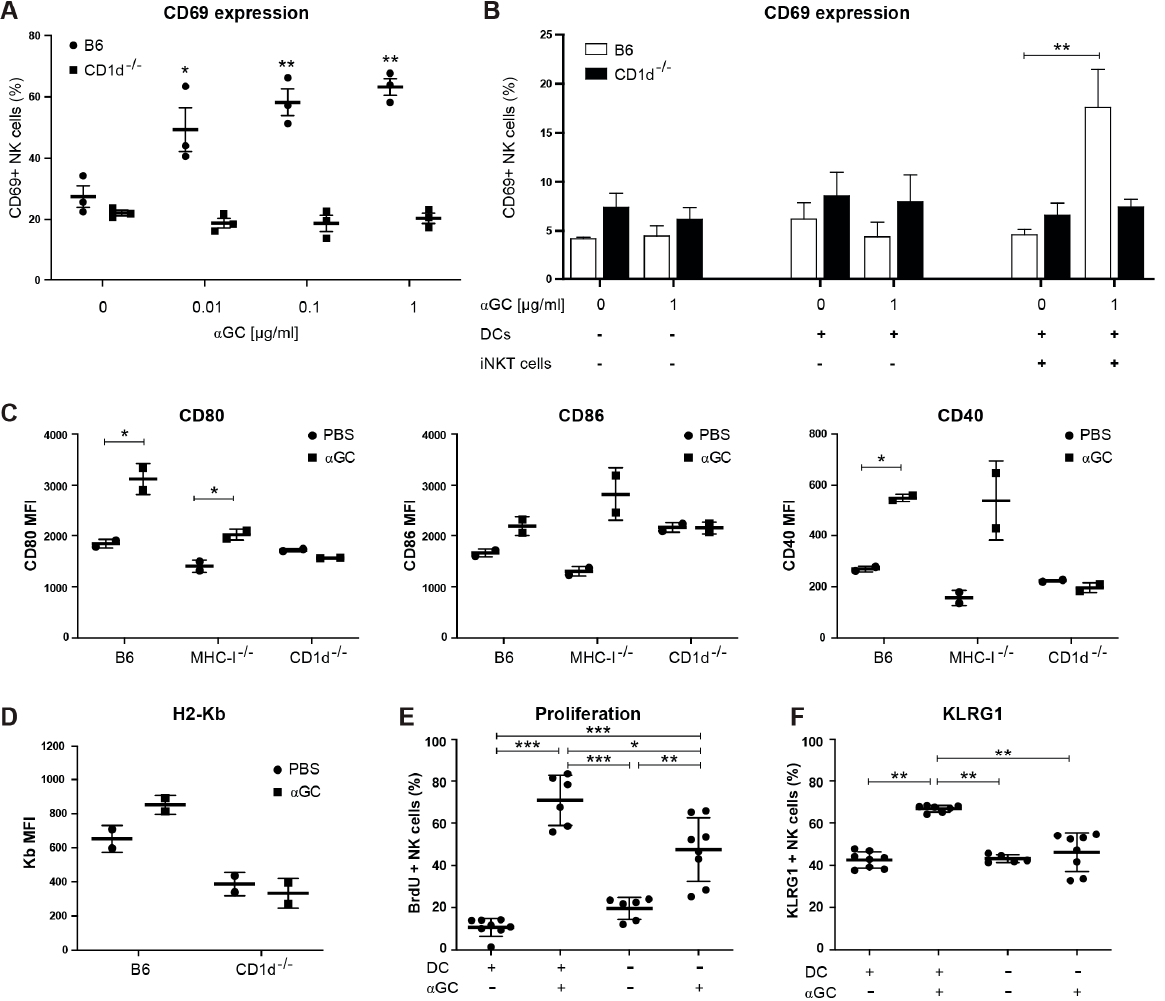
Figure 3. Dendritic cells (DCs) are activated by α GC in vivo and contribute to NK cell activation in vitro and in vivo. ( A ) Spleen cells of B6 and CD1d − / − were isolated and cultured in vitro in the presence of absence of α GC (00.1, 0.1, 1 µg/mL), and CD69 expression measured on NK cells after 48h. ( B ) Spleen cells were isolated and sorted by magnetic bead sorting. NK cells were cultured alone, or in the presence of DCs and/or iNKT cells and in the presence or absence of α GC (1 µg/mL). CD69 expression was measured on NK cells after 24 h by flow cytometry. ( C , D ) C57Bl/6 mice were injected i.v. with PBS or with 200 ng soluble α GC. cDCs were stained at day 2 by excluding dead, CD3 + NK1.1 + CD19 + Ter119 + cells, and then gated on CD11c high CD11b low CD8a + cDCs. MFI of CD80, CD86 and CD40 ( C ) and H2-Kb ( D ). One representative experiment of 2 performed. ( E , F ) CD11c.DOG mice were treated with PBS (DC + ) or DTR (DC − ) for 7 days and received PBS or 200 ng of α GC and were fed BrdU via the drinking water from day 3. BrdU incorporation ( E ) or KLRG1 expression (f) was measured on day 7. Data are from 3 mice per group from one experiment ( A , B ), from 2 mice per group from one experiment ( C , D ), and 6–8 mice per group from two experiments ( E , F ). Statistical differences were calculated using one-way ANOVA with Tukey’s correction for multiple testing ( A , B ), where all groups where compared to the untreated B6 control group, unpaired two-tailed t -test ( C , D ), or one-way ANOVA with Tukey’s correction for multiple testing for ( E , F ). Error bars indicate mean ± SD and statistical significance is indicated as * p < 0.05, ** p < 0.01. *** p < 0.001.